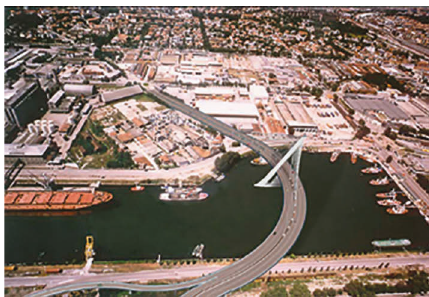
Figure 7: The curved cable-stayed bridge of the Porto Marghera (Venice, Italy).